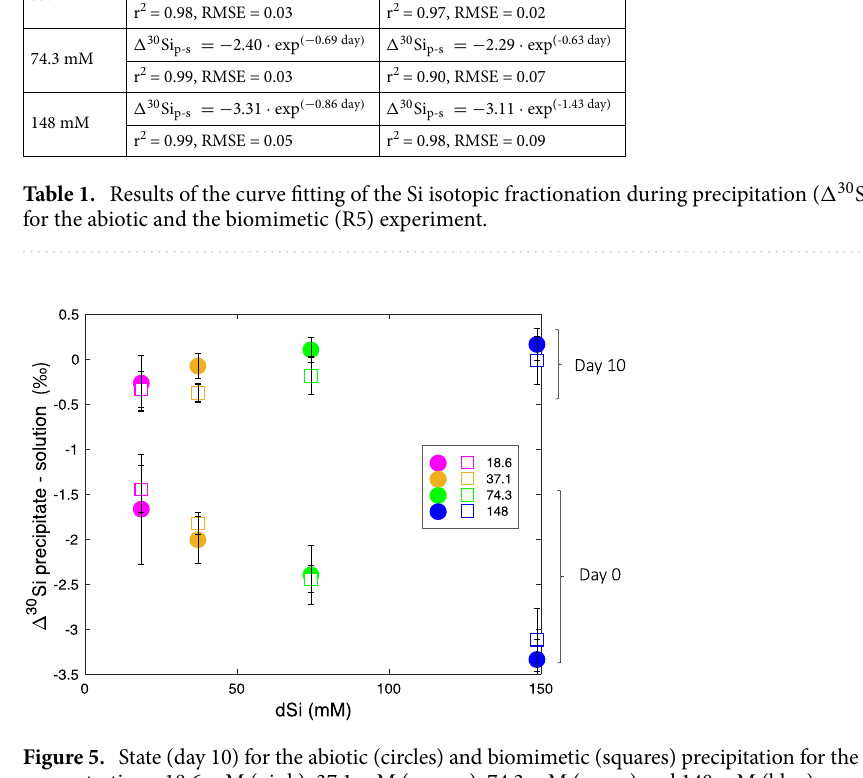
Figure 5. State (day 10) for the abiotic (circles) and biomimetic (squares) precipitation for the four different Si concentrations, 18.6 mM (pink), 37.1 mM (orange), 74.3 mM (green) and 148 mM